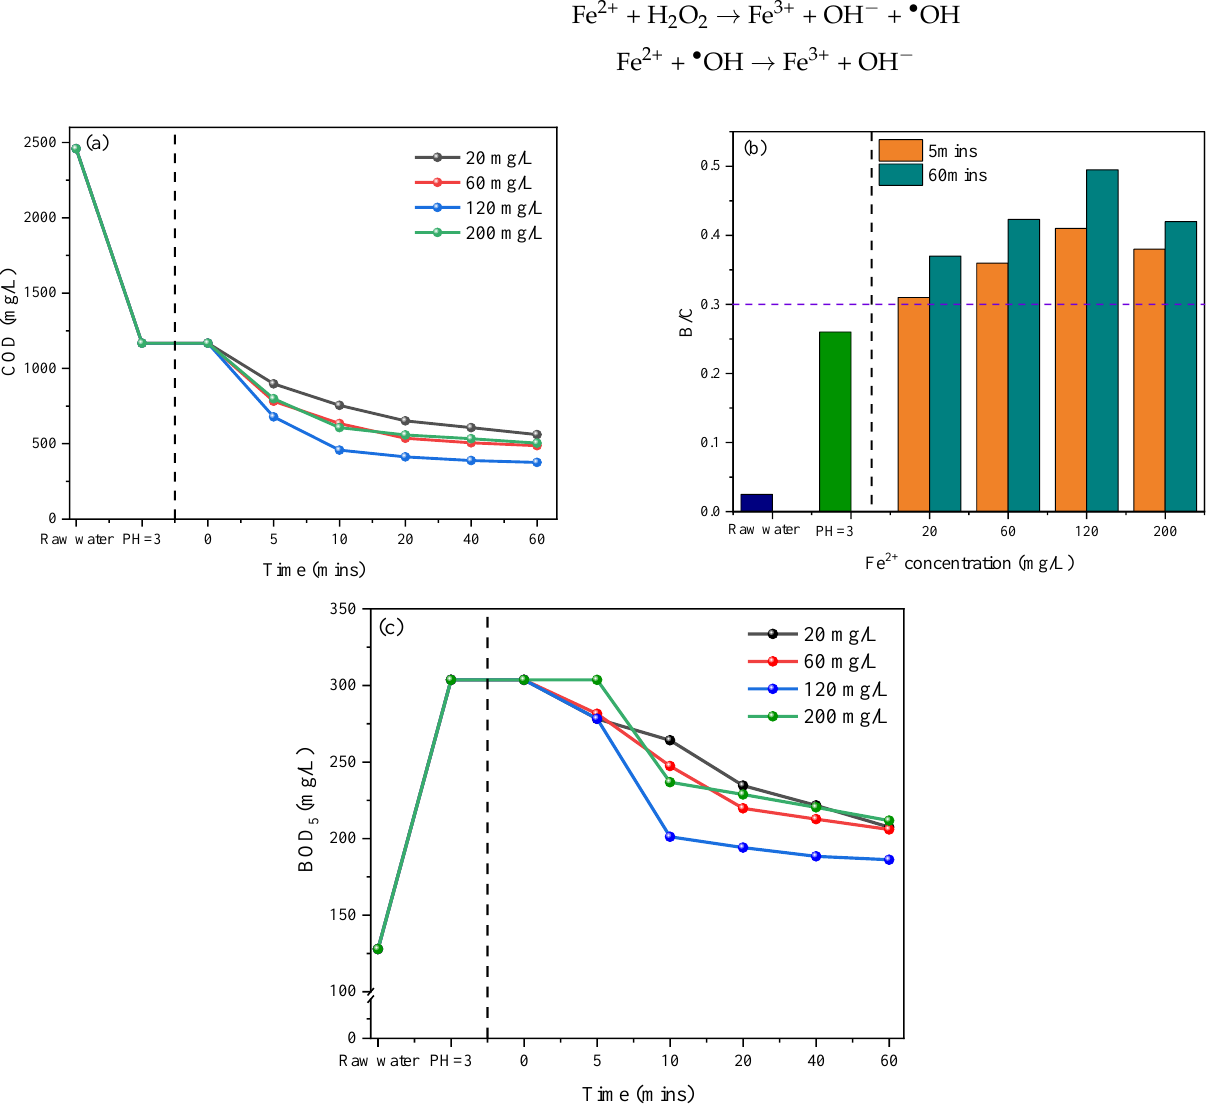
Figure 1. Effect of Fe 2+ concentration on ( a ) COD removal; ( b ) B/C values; ( c ) BOD 5 variation during Fenton oxidation. Conditions are as follows: H 2 O 2 concentration 300 mg/L; 250 mL wastewater; pH = 3.0.